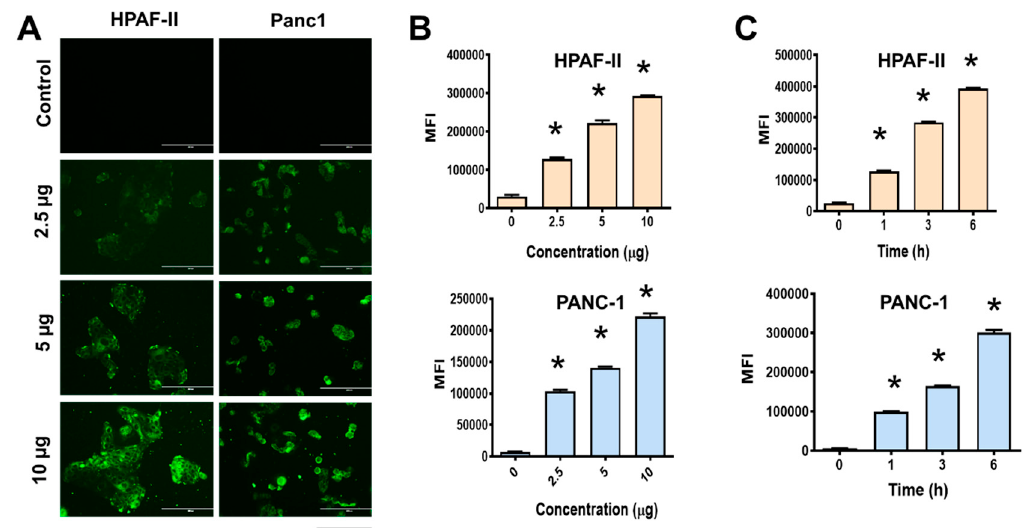
Figure 4. Cellular uptake of MPT-NCs by pancreatic cancer cell lines. Coumarin-6 dye was conjugated with MPT-NCs to image and track nanoparticles under a microscope and by flow cytometry. ( A , B ) Dose dependent cellular uptake behavior of MPT-NCs in HPAF-II and PANC-1 cells. ( A ) Fluorescence images and ( B ) flow cytometry-based cellular update phenomenon of 2.5, 5, and 10 µ g Coumarin 6-containing MPT-NCs for 3 h of incubation. The scale bar on fluorescence images indicates 200 µ m. ( C ) Flow cytometry cellular uptake pattern of 5 µ g Coumarin 6-containing MPT-NCs at 1, 3, and 6 h, respectively. Data are expressed as the mean ± SEM, n = 3. * p < 0.05 of MPT-NCs treatment vs. control